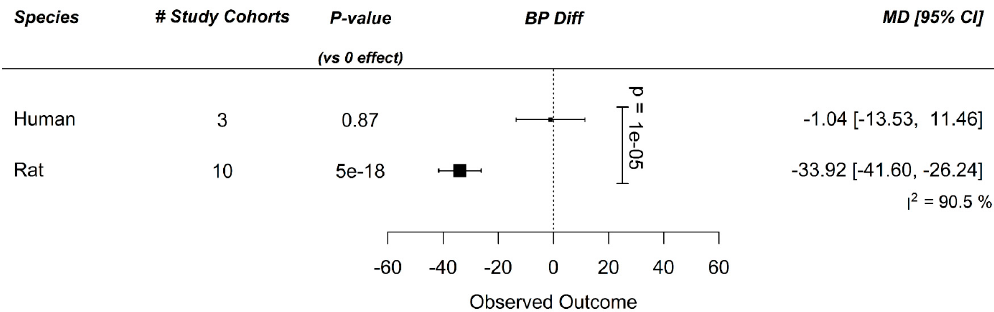
Figure A5. Species meta-regression of amino acids (AA) in arginine family on maternal blood pressure (BP) in pregnancy complications. Meta-regression revealed large interspecies differences, although only two human study cohorts versus seven rat study cohorts reported on the effect of prenatal supplementation of AA of the arginine family in complicated pregnancies. Data represent pooled estimates expressed as mean difference (MD) with 95% confidence interval (CI) using a random effect model. I 2 , heterogeneity.